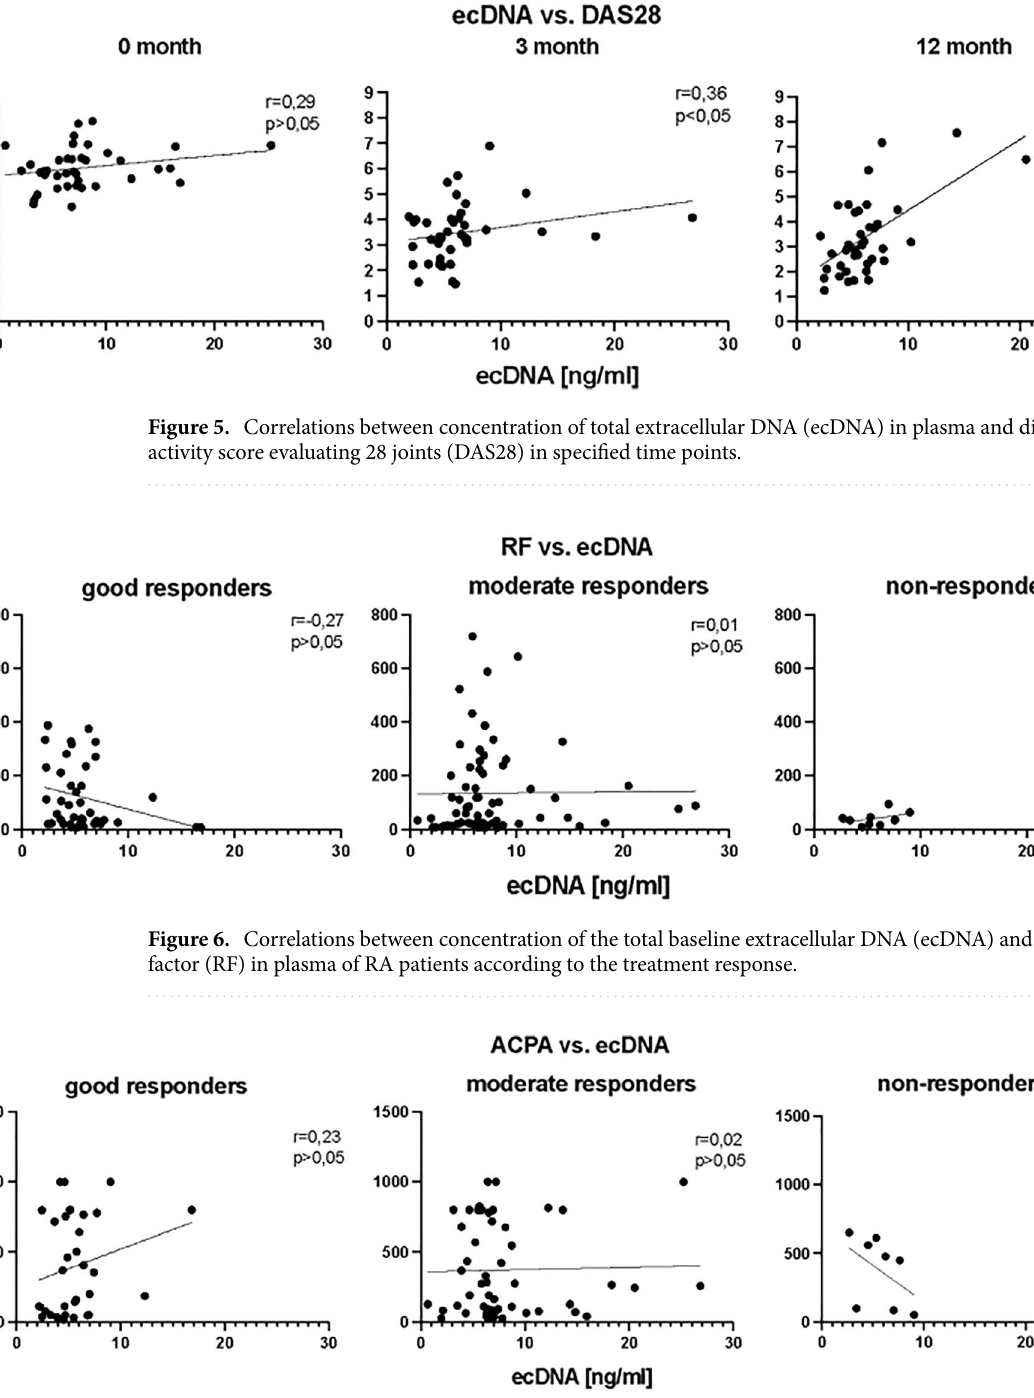
Figure 7. Correlations between concentration of the total baseline extracellular DNA (ecDNA) in plasma and anti-citrullinated protein antibodies (ACPA) of RA patients according to the treatment